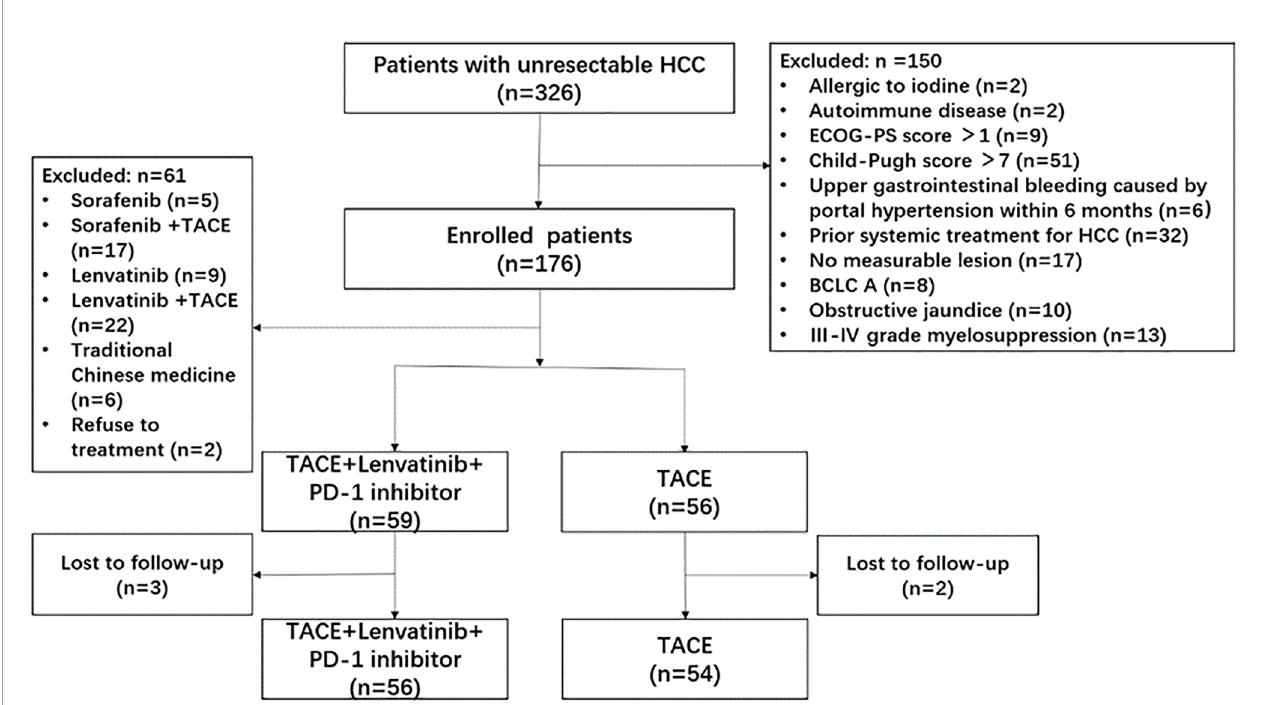
FIGURE 1 | Flowchart of the patient selection process. HCC, hepatocellular carcinoma; ECOG-PS, Eastern Cooperative Oncology Group performance status; BCLC, Barcelona Clinic Liver Cancer; TACE, transcatheter arterial chemoembolization; PD-1, programmed cell